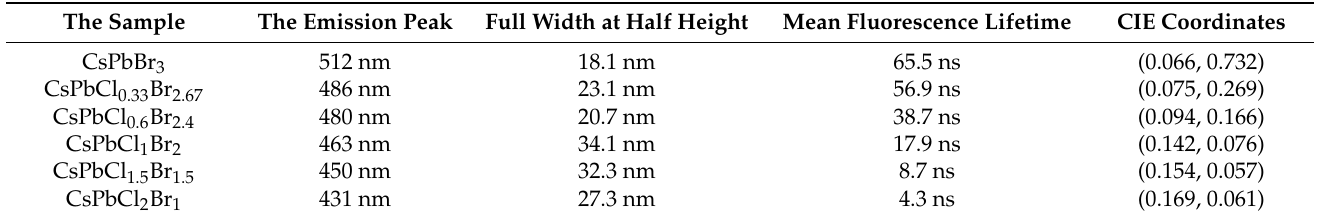
Table 1. Luminescence data of CsPbCl x Br 3-x nanocrystals based on different halogen